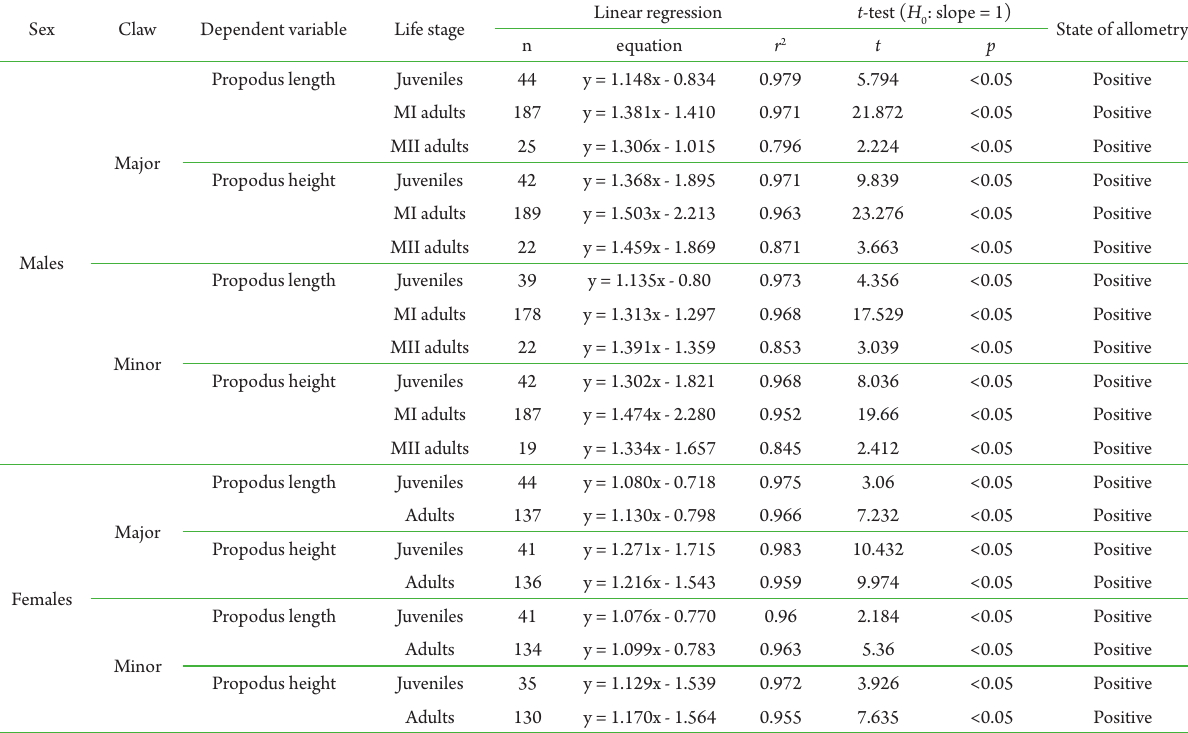
Table 1. Linear regression (ln Chela dimension against ln Carapace length) equations and respective values of coefficient of determination ( r 2 ) and state of allometry in males and females of Aegla castro for each dependent variable. M = morphotype. Sex Claw Dependent variable Life